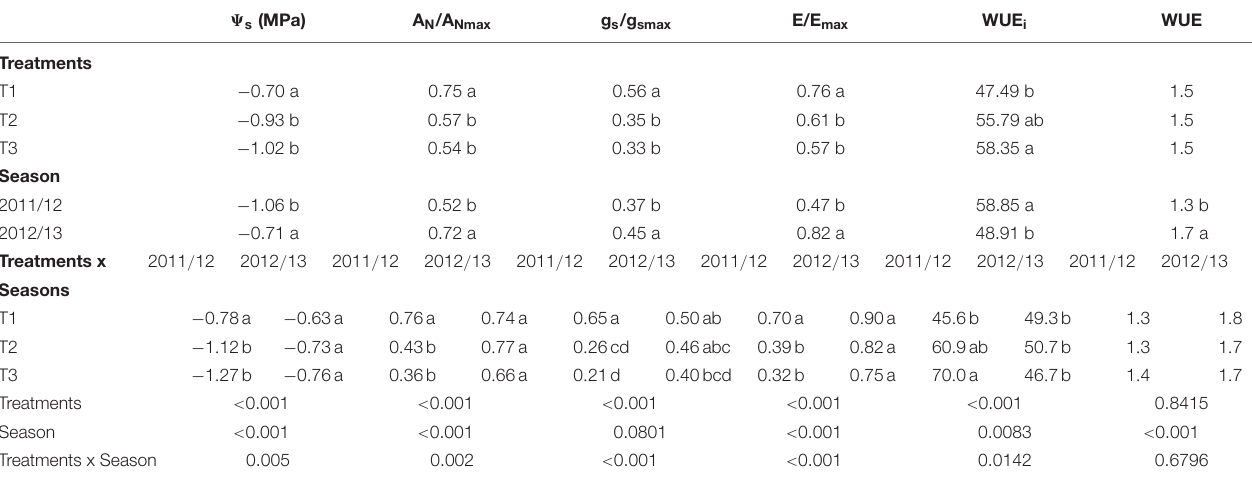
TABLE 4 | Effect of three levels of water application on physiological variables from setting (S) to veraison (V) period of a drip-irrigated Carménère